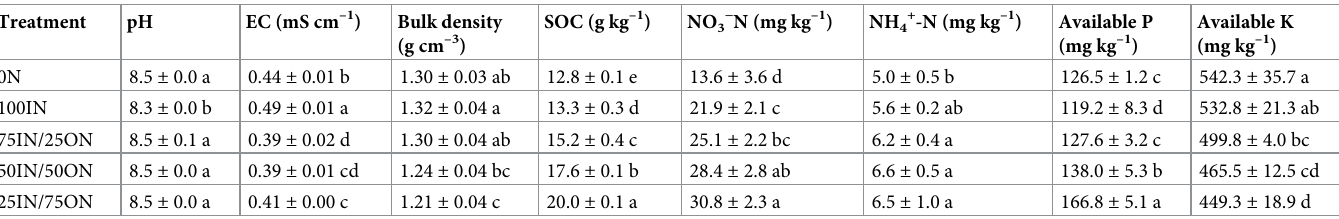
Table 4. Changes in soil physicochemical characteristics under different fertilization treatments after celery harvest in January 2017 (the fifteenth-season). Data are means ± S.E., n = 3. Different lowercase letters indicate significant differences among different treatments at the P < 0.05 level. Treatment